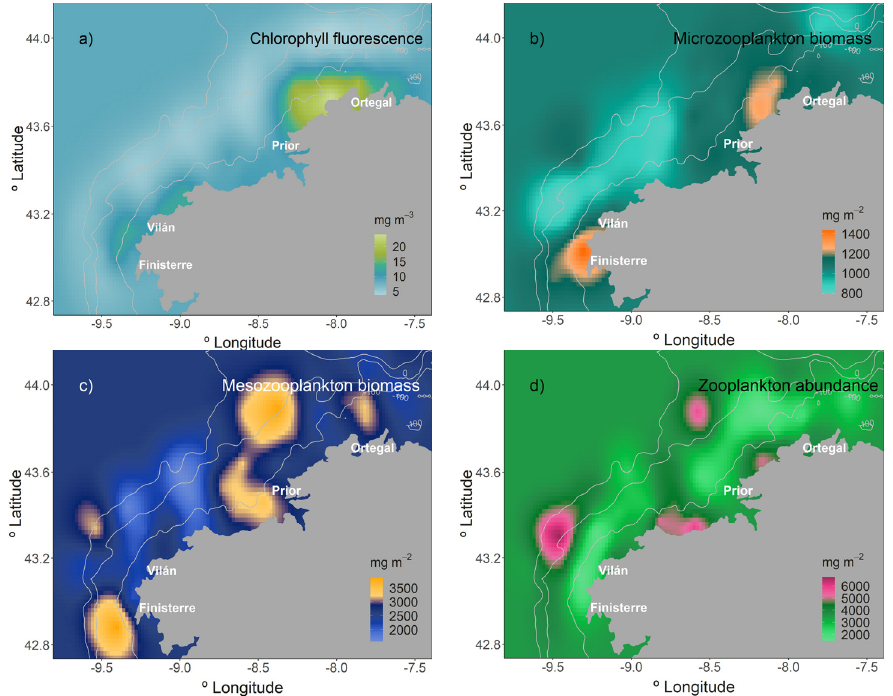
Figure 3. ( a ) Chlorophyll fluorescence, ( b ) microzooplankton biomass, ( c ) mesozooplankton biomass, ( d ) mesozooplankton abundance.